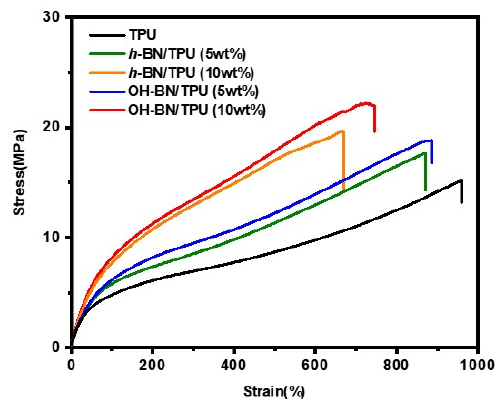
Figure 6. The stress–strain dependence of pure TPU compared with the h -BN/TPU and OH-BN/TPU composites (at 5 and 10 wt.% filler concentrations).